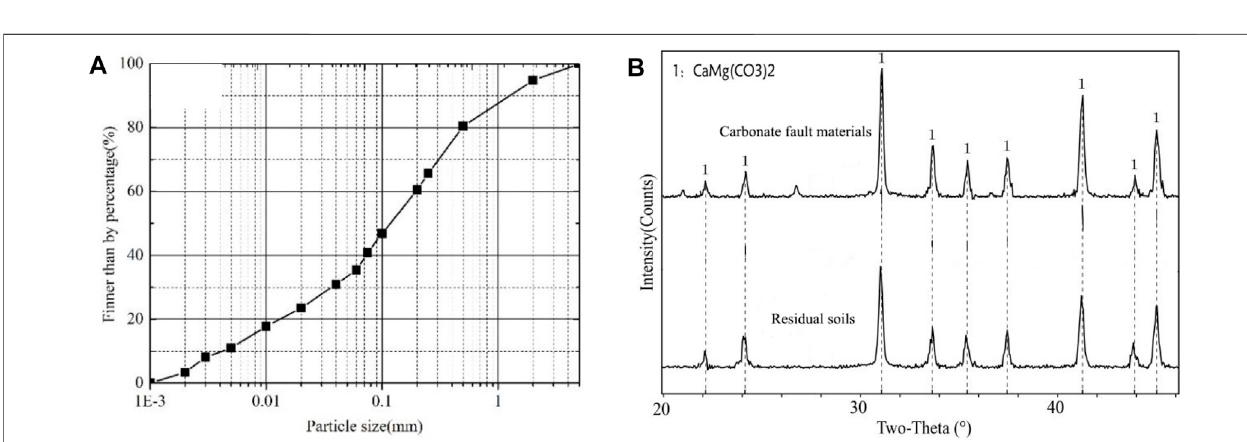
Frontiers in Earth Science |